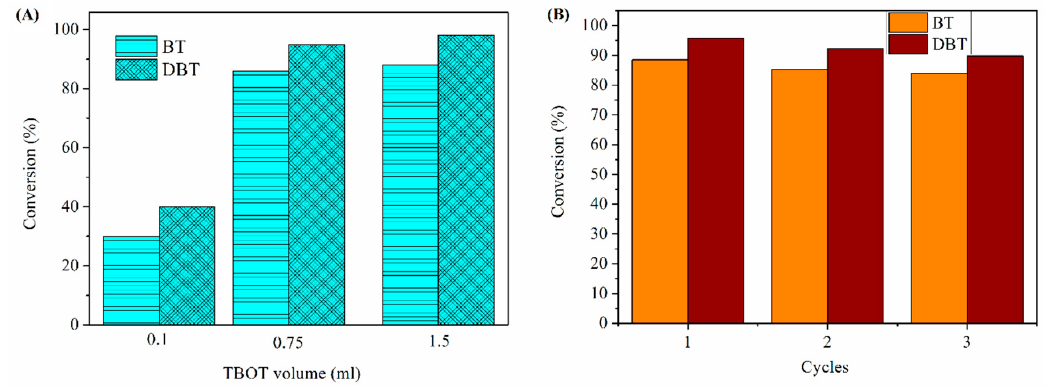
Figure 10. The effect of Ti amount on BT/DBT conversion ( A ) and reusability of Cu-BTC@TiO 2 ( B ).